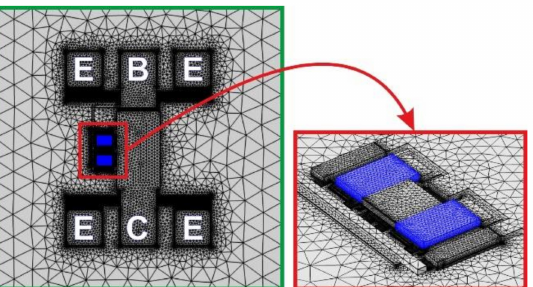
Figure 5. ( Left ) Two-cell test device built in the COMSOL environment ( mesh mode ). The numbers of elements (tetrahedra) and degrees of freedom (DoFs) are 2.4 × 10 6 and 3.3 × 10 6 , respectively. ( Right ) Magnification of the two unit cells. A horizontally-large substrate (not fully represented in the figure) was considered to safely neglect the effect of the lateral adiabatic sides on the temperature field over the base-emitter junction.